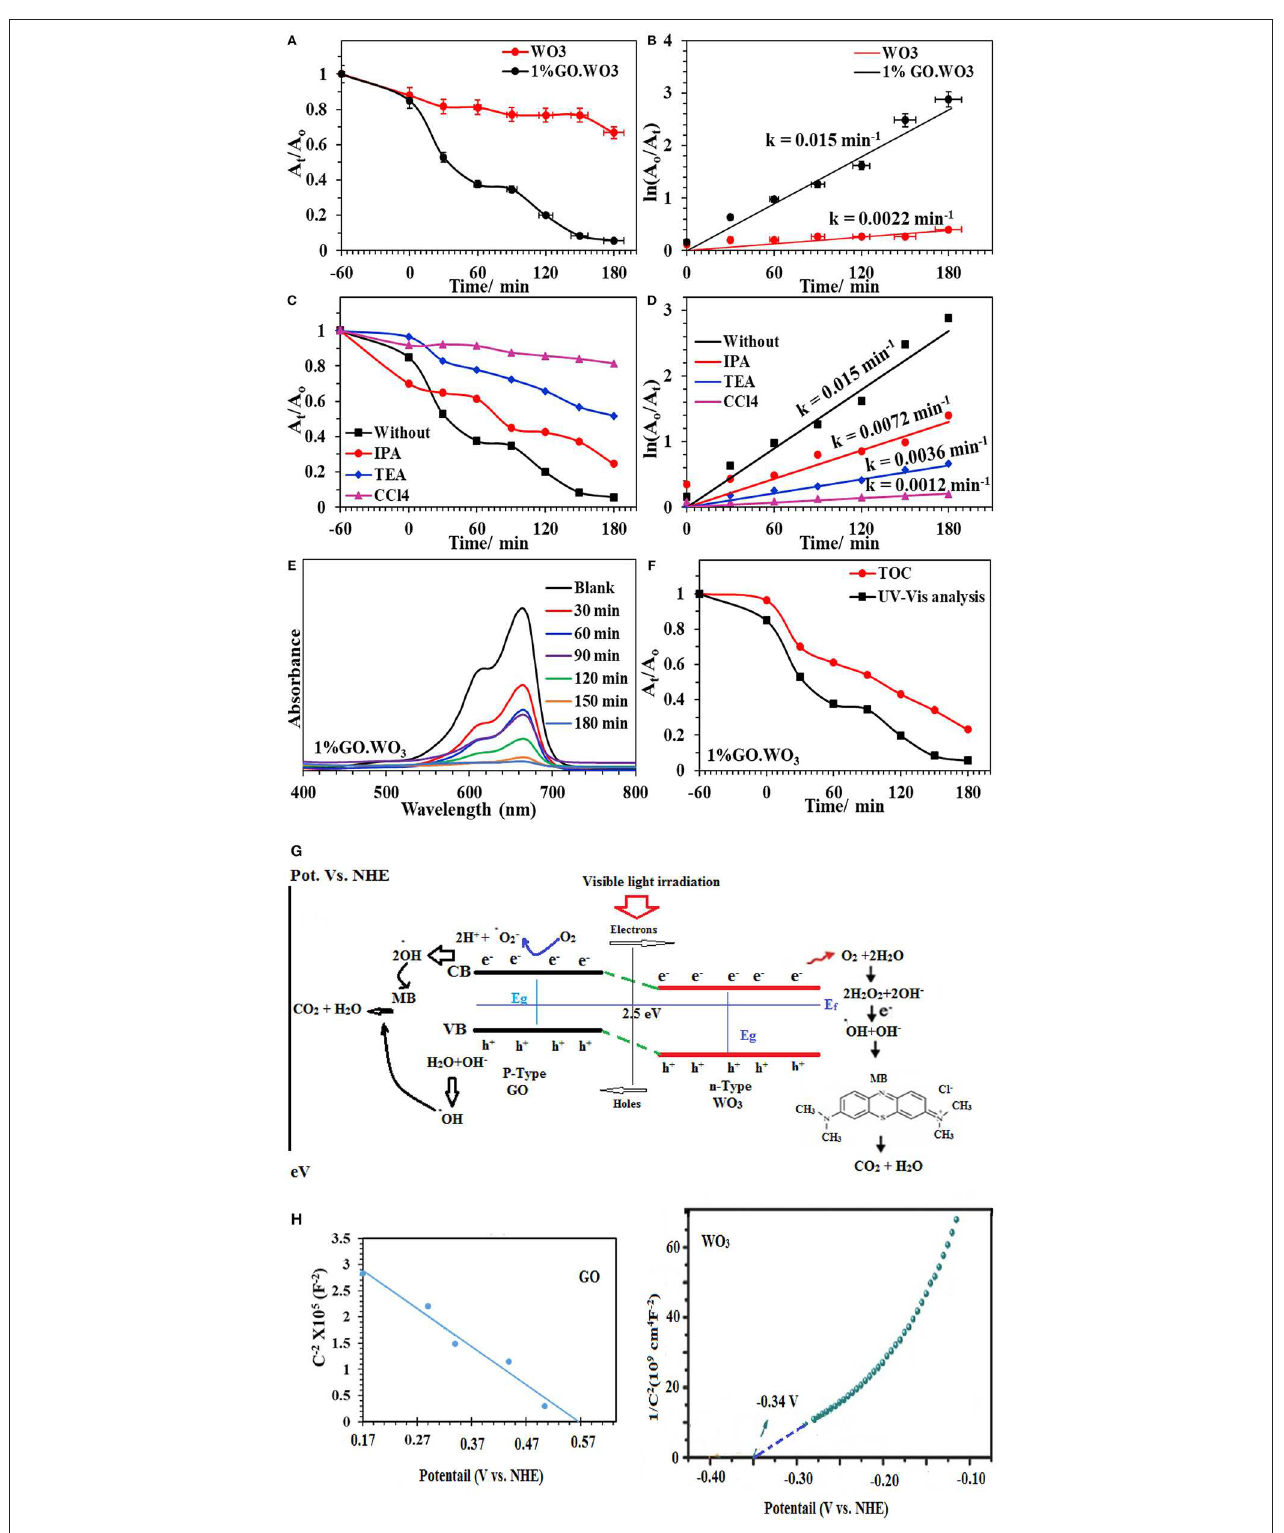
FIGURE 7 | A t /A o plot of the MB (20 ppm) degradation over WO 3 and 1%GO.WO 3 catalysts at the dose of 1.0 g/l under visible light illumination (160W, λ > 420) (A) and their kinetic curves of ln A o /A t vs. time (B) Effect of scavengers on the catalytic degradation of MB over 1%GO.WO 3 with time (C) and their kinetic curves with time (D) beside UV-Vis. absorbance spectra of the MB over 1wt% GO.WO 3 with time (E) , Decrease in TOC and change in absorbance as function of irradiation time for the MB dye (F) , the expected reaction mechanism of the MB degradation over 1%GO.WO 3 (G) and Mott–Schottky plots of WO 3 and GO (H) .